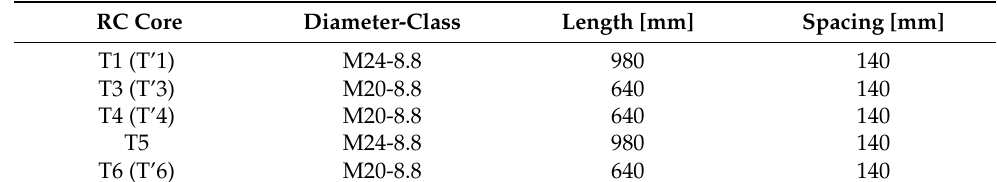
Figure 15. Structural detail of the horizontal steel strips applied to the concrete wall.